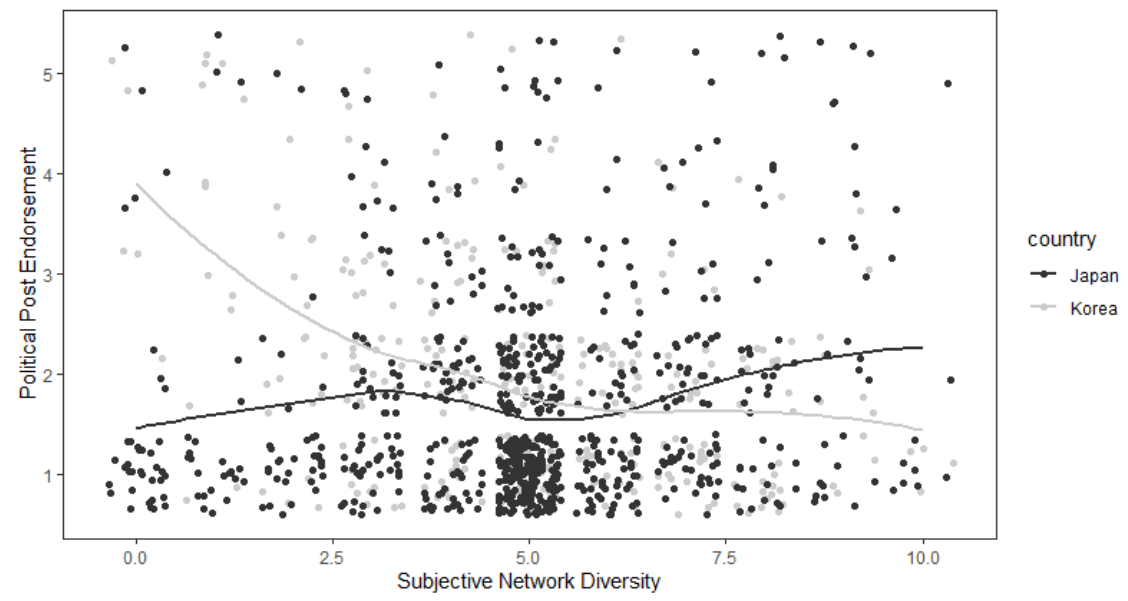
Figure 1. Jitter Plot of SND and Endorsing Behavior by